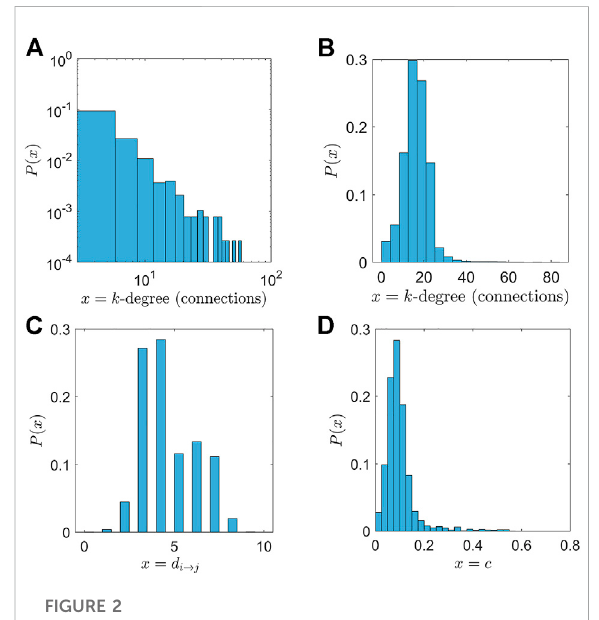
FIGURE 2 Statistical properties of the connectivity network. (A) The degree distribution (depicted in logarithmic scale) follows a power law as Eq. 1 with critical exponent γ = 2.54. (B) The augmented network, using a small world network for the internal connectivity. The resulting distribution is a combination of power laws, meaning that the central nodes still exist and act as hubs. Furthermore, each neuron is connected on average with the 20 nearest neighbours in a radius of 5 mm. (C) The distribution of path lengths in the network. The mean value was calculated as ml = 4.43. (D) The distribution of clustering coef fi cients. There are few nodes with a high value of clustering coef fi